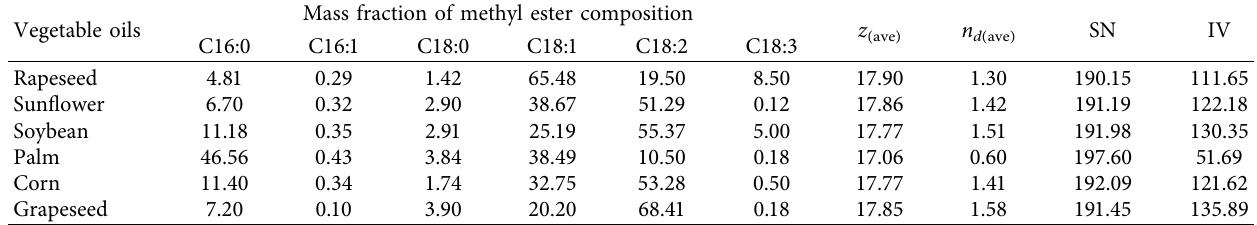
Table 2: Te proposed vegetable oil composition and its average number of carbon atoms, number of double bonds, saponifcation number, and iodine